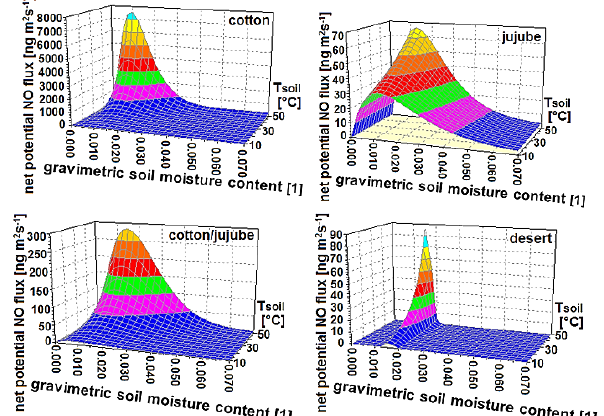
Figure 2. Net potential NO fluxes F NO (ngm − 2 s − 1 ; in terms of mass of nitric oxide) from soils of the four major land-cover types of Milan oasis as functions of soil temperature ( ◦ C) and dimensionless gravimetric soil moisture